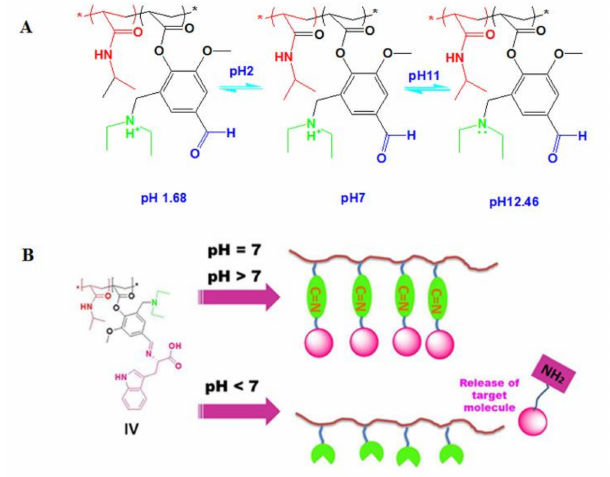
Figure 10. Change of transmittance with temperature (turbidity) for determination the T c and C p of P (NIPAAm- co -DEAMVA) with different mol % of DEAMVA at pH 1.68, pH 7 and pH 12.46 ( A , B ), P (NIPAAm- co -DEAMVA)- g -tryptophan with 10 mol % of DEAMVA ( C ), and poly (NIPAAm- co -DEAMVA)- g -tyrosine with 10 mol % of DEAMVA ( D ) using UV-Vis spectroscopy for 1 wt % of polymer solution.